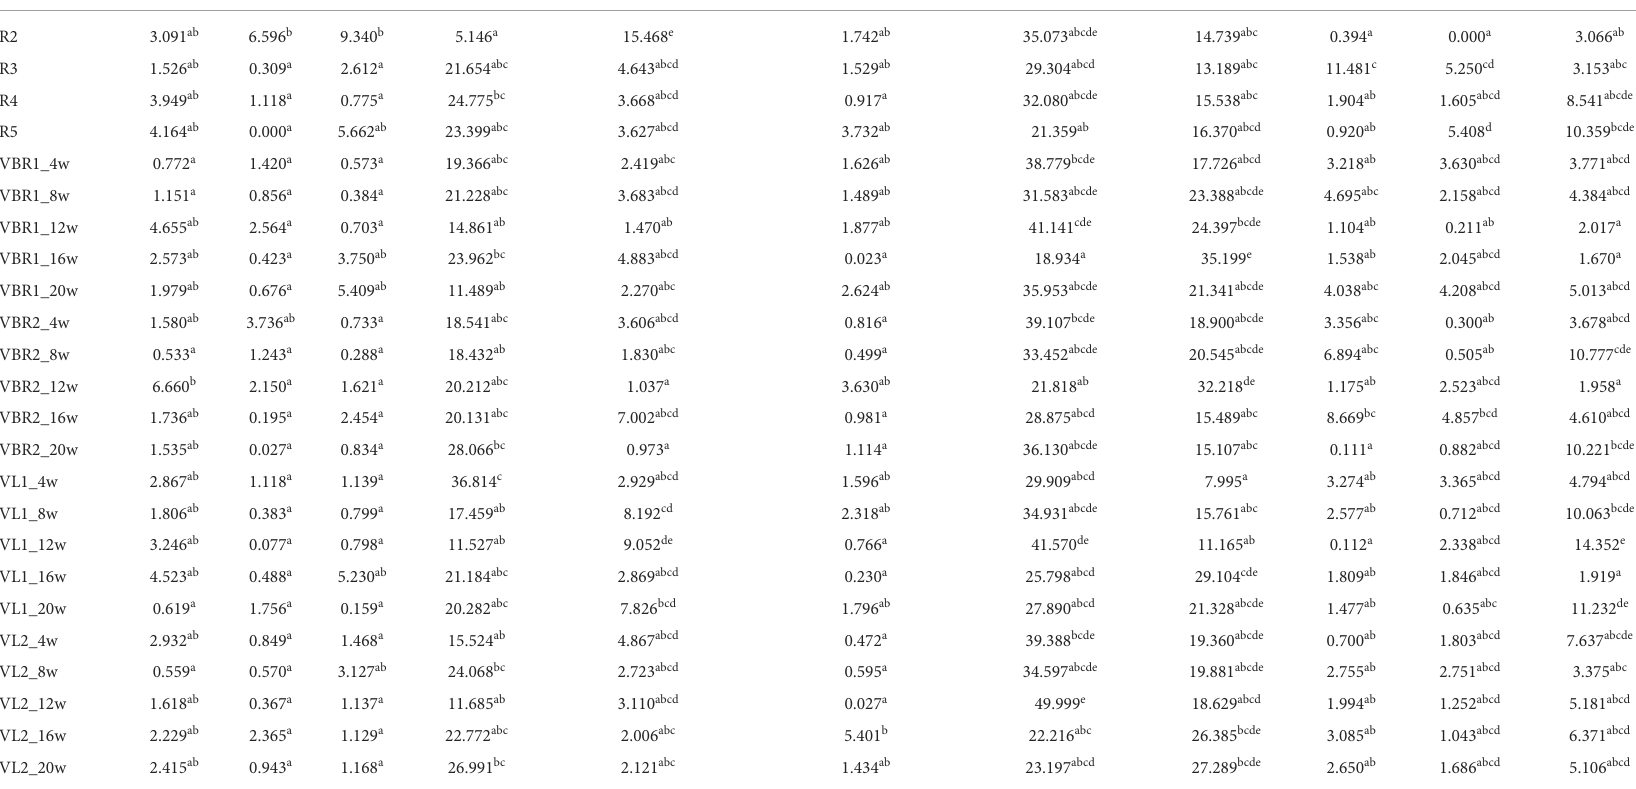
TABLE 1 Main groups of carbon sources utilized by soil microbial communities in the various soil samples of landraces and over different growth stages over time. Soil samples Alcohols Amides Amines Amino acids Aromatic chemicals Brominated chemicals Carbohydrates Carboxylic acids Esters